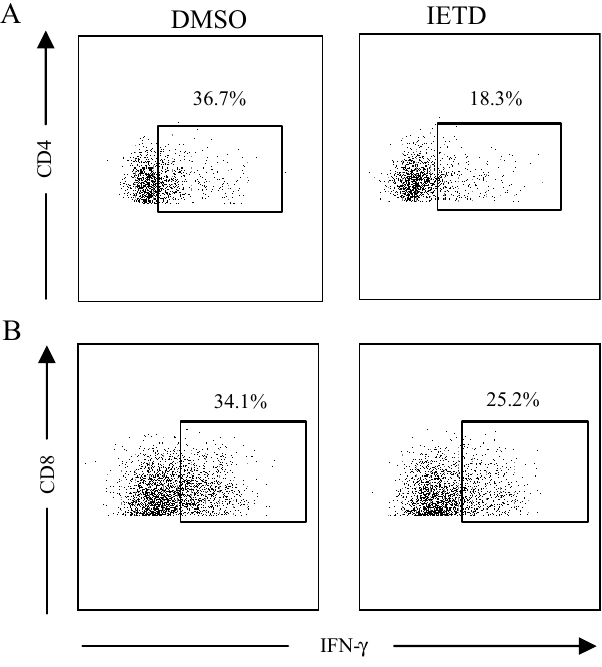
Fig. 5–Inhibitionofcaspase-8reducesIFN- γ expressionbyTcellsfrom L.major infectedmice. Lymph node cells from infected (2 wk) mice were stimulated with anti-CD3 in the presence of zIETD (right panels) or stock diluent DMSO (left panels), re-stimulated as described above and stained with anti-CD4 (A), anti-CD8 (B) and anti-IFN- γ (A and B). Panels show percentages of IFN- γ + CD4 T cells (A), and IFN- γ + CD8 T cells (B) as assessed by flow